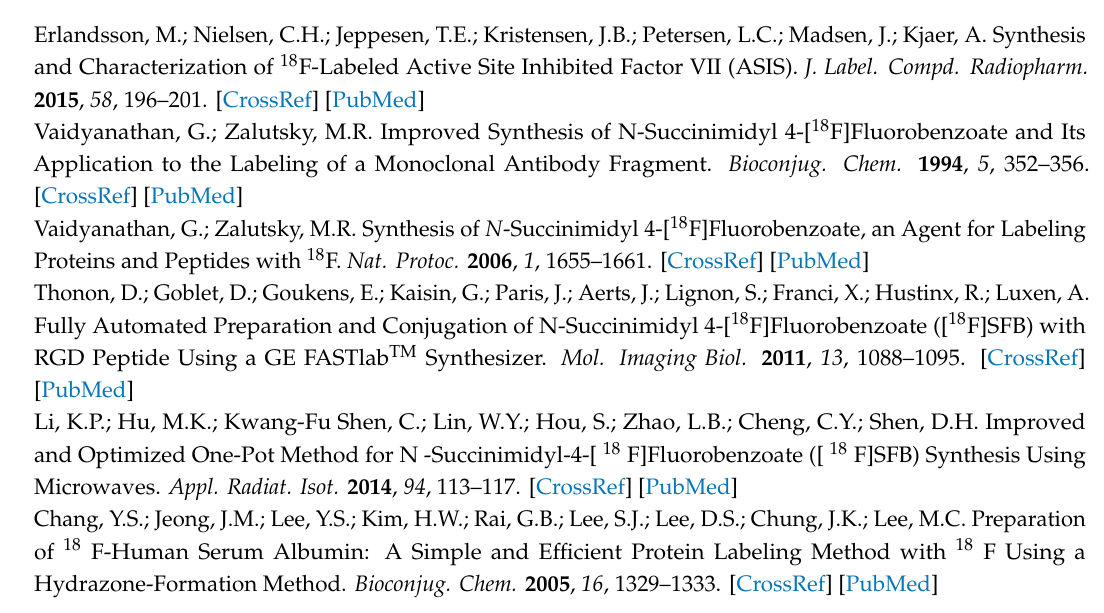
Supplementary Materials: Analytical HPLC and NMR data, additional experimental data including analytical HPLC conditions and reaction optimization attempts are